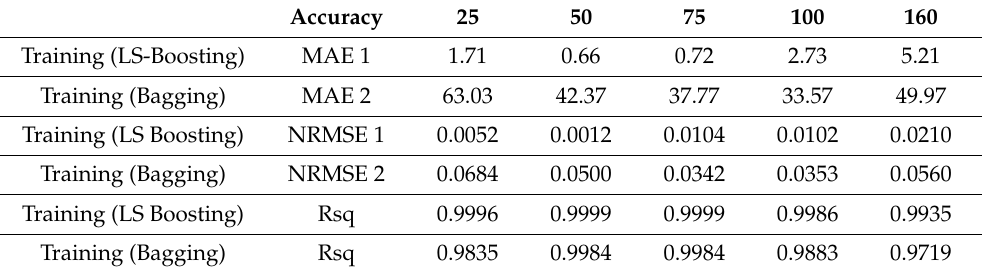
Table 6. Throughput data training accuracy using LS-Boosting and bagging.